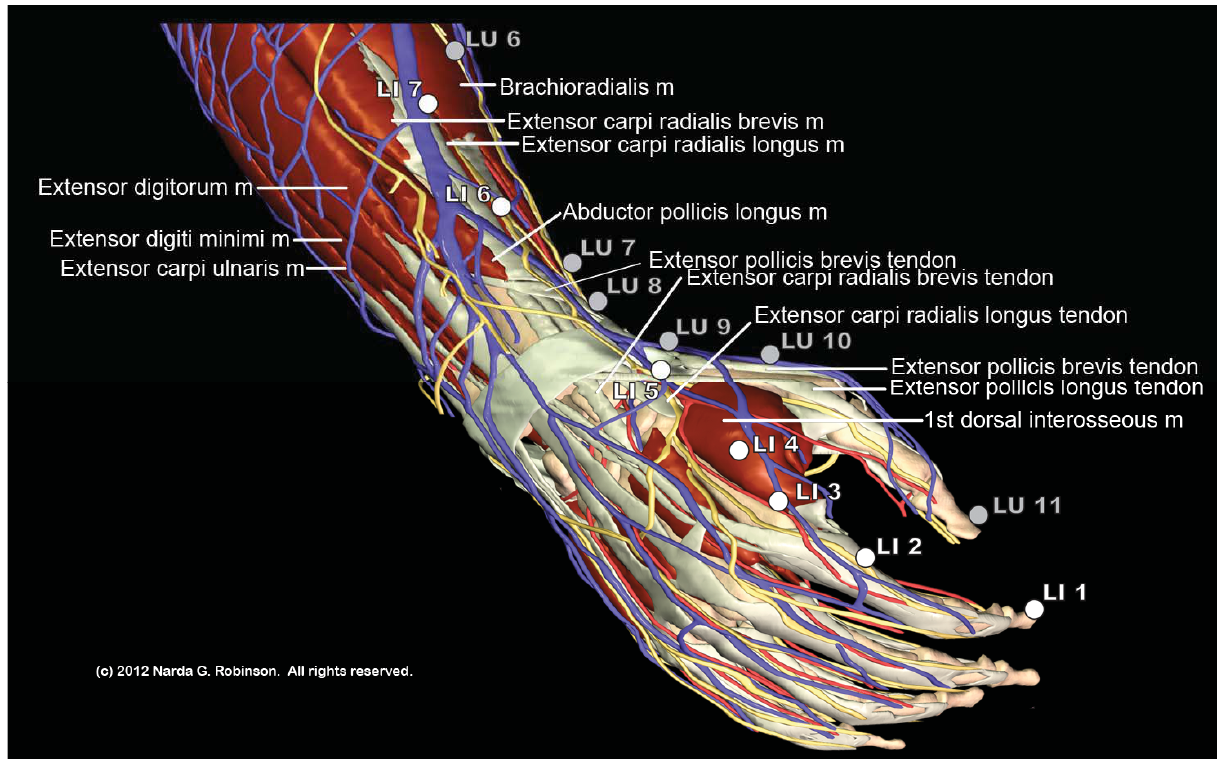
Figure 6. Comparative anatomy calls into question the transposition of many points from the human hand and foot to the equine digit. This image highlights distal points on the Large Intestine (LI) and Lung (LU) channels, all of which should likely be omitted in the horse. Specifically, this entails LI 1 through LI 4, LU 10, and LU 11. (Image courtesy of Narda G. Robinson, DO, DVM, MS and Teton NewMedia. From